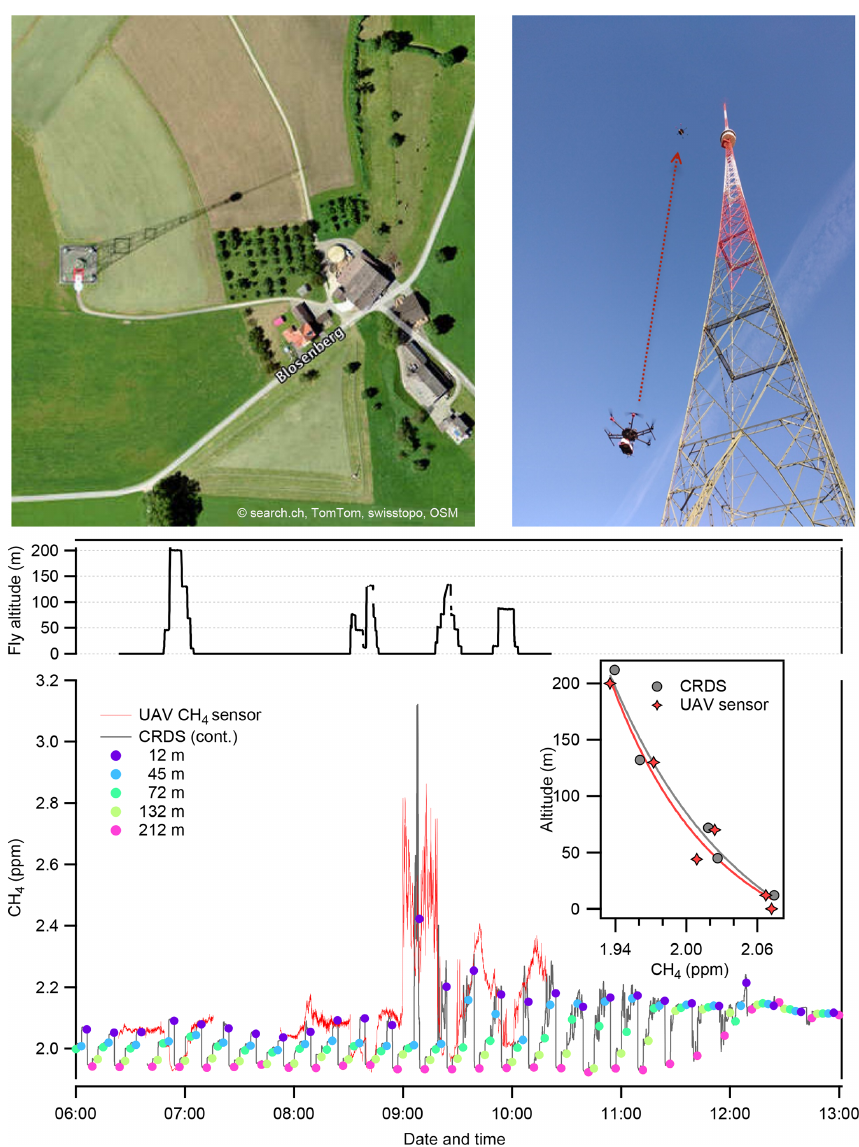
Figure 8. Satellite image of the area used for profiling (top left). Photograph of the drone flying at various heights in the vicinity the radio tower (212m) at Beromünster (top right). Vertical profile measurements of atmospheric methane (bottom). The concentration gradient is clearly observable until noon, when the nocturnal boundary layer is broken up by convective vertical mixing. The gray trace represents the continuous, while the colored dots indicate the mean CH 4 concentration values at various heights as measured by a ground-based CRDS analyzer. The UAV methane instrument (red trace) performed four flights covering the altitude span between 0 and 200m. The inset shows the comparison of the profile data collected by the two analyzers. The concentration gradient is well captured in both